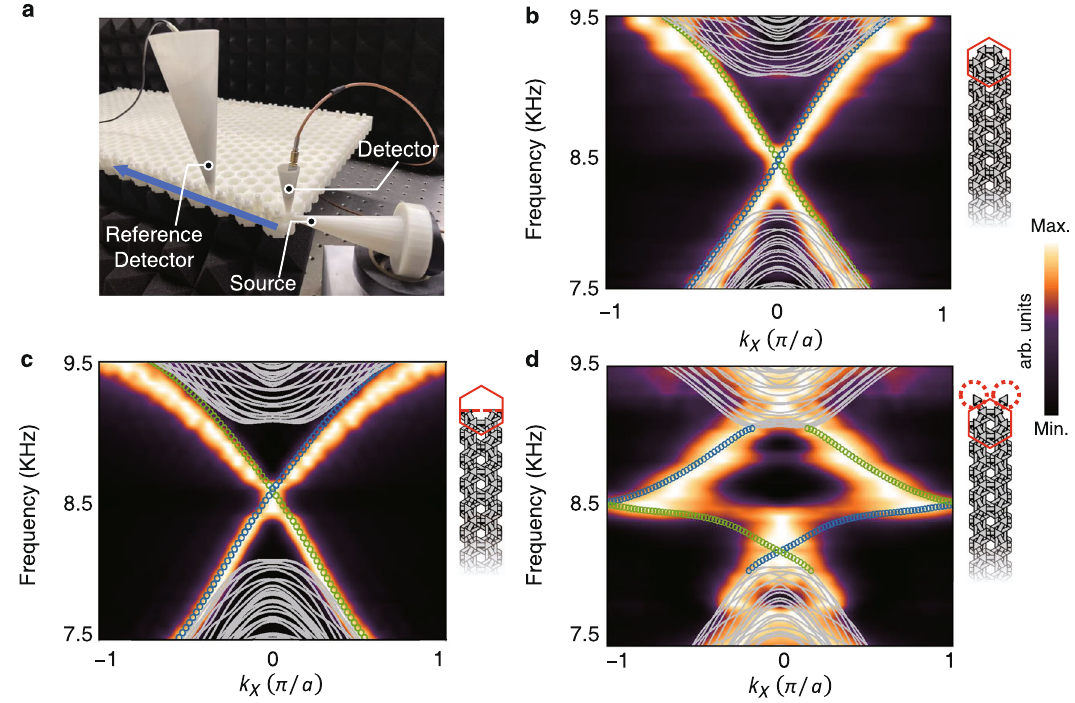
Fig. 4 | Robustness ofideal helical edge states. a Experimental setup to measure the dispersion. The blue arrow marks the acoustic propagation. b Experimentally measured band structures with intact boundary along the x- direction. The colour scale represents the strength of the acoustic energy density with arbitrary units